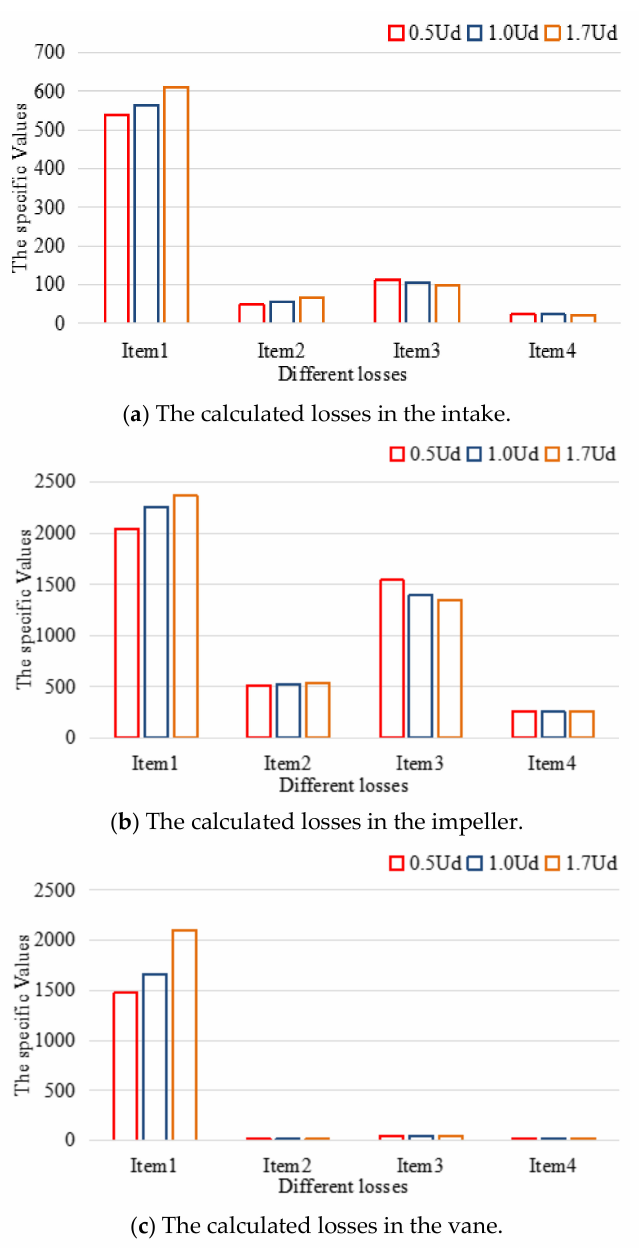
Figure 9. The calculated losses in different hydraulic